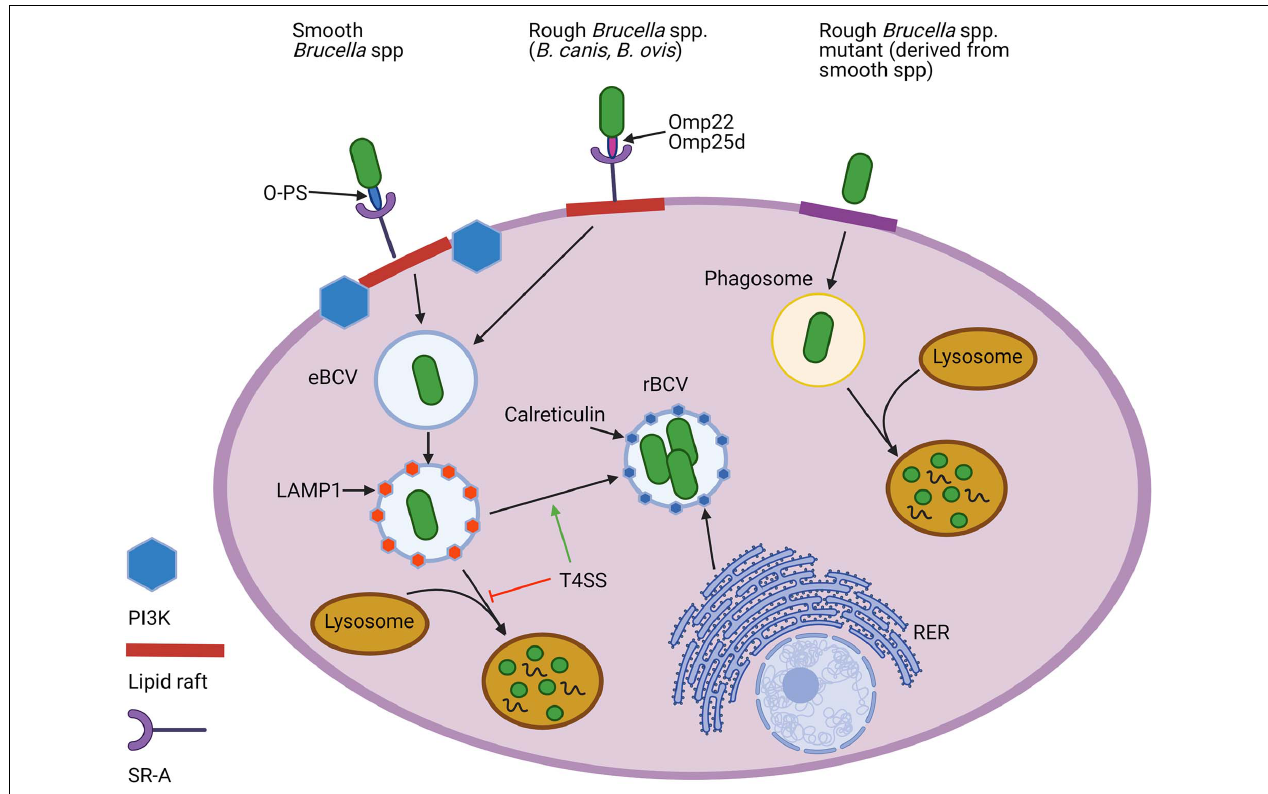
FIGURE 3 | Cellular entry and intracellular trafficking of natural rough and smooth Brucella spp. and rough mutants derived from smooth strains. Both natural smooth and rough Brucella spp., but not rough mutants, enter macrophages using lipid rafts and utilize the scavenger receptor, SR-A, to do so. While the O-polysaccharide (O-PS) serves as the ligand for this interaction for smooth strains, rough Brucella spp. appear to rely on outer membrane proteins (Omps), including Omp22 and Omp25d. Lipid raft-mediated entry for smooth, but not natural rough Brucella spp., is reliant on the activity of phosphoinositide-3-kinase (PI3K). Once internalized, Brucella become engulfed in an endosomal Brucella -containing vacuole (eBCV) that alter associates with LAMP1. Expression of the type 4 secretion system (T4SS) allows some of the smooth and natural rough Brucella to avoid destruction by lysosomes and later associate with components of the rough endoplasmic reticulum (RER), such as calreticulin, to establish a replicative vacuole, or rBCV. In contrast, most rough mutants are unable to avoid lysosomal fusion and do not exhibit intracellular replication. Created with